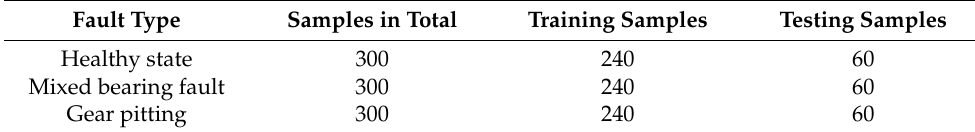
Table 10. Fault types and sample size for training and testing SOM on rotary torsional fatigue test. Fault Type Samples in Total Training Samples Testing Samples Healthy state 300 240 60 Mixed bearing fault 300 Gear pitting 300 240 60